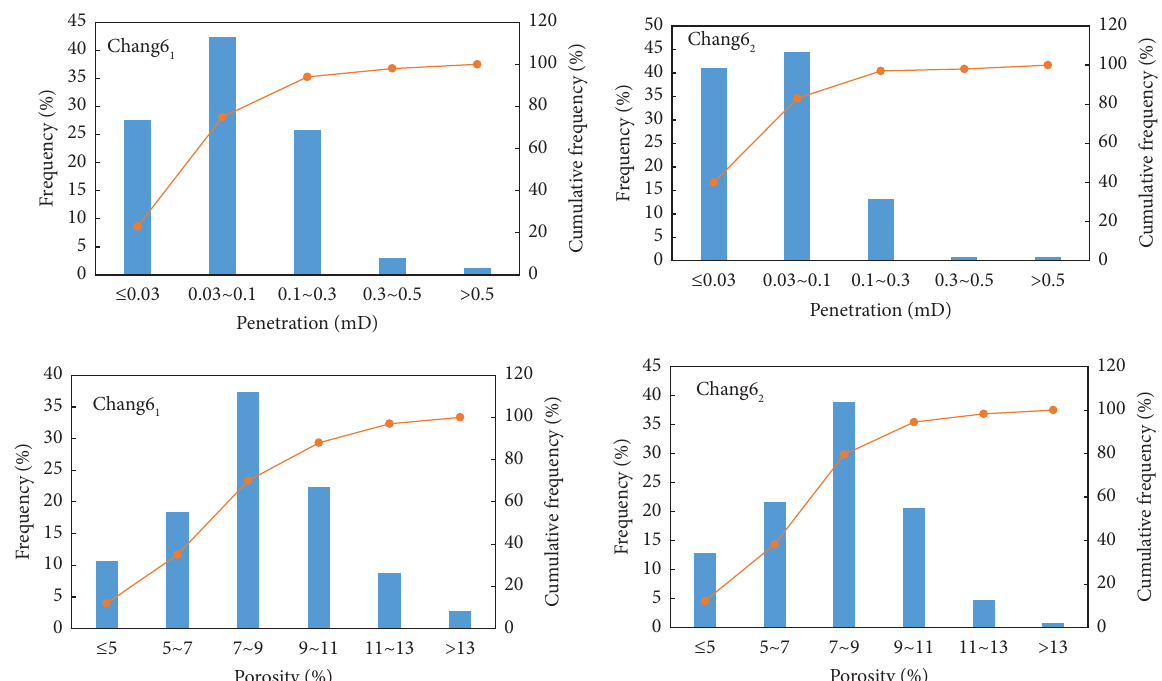
Figure 7: Porosity and permeability distribution histogram of the Chang 6 submember of Yanchang Formation.